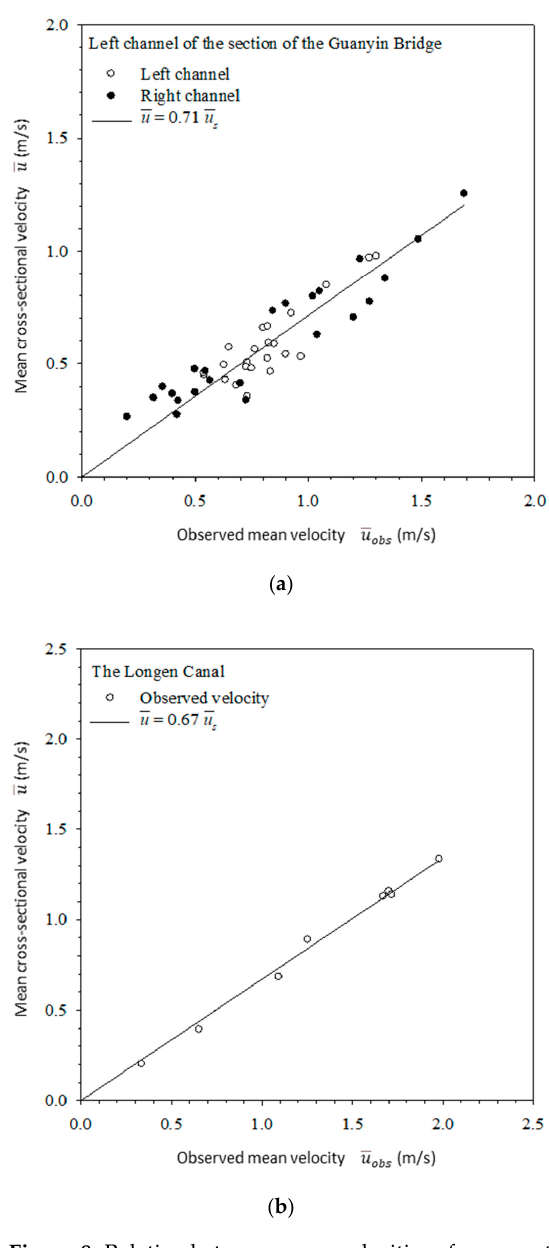
Figure 8. Relation between mean velocities of cross section and surface. ( a ) the Nankang River at the Guanyin Bridge; ( b ) the Longen Channel. Nangang Creek is a mountain river at Guanyin Bridge, with steep slopes and contin-